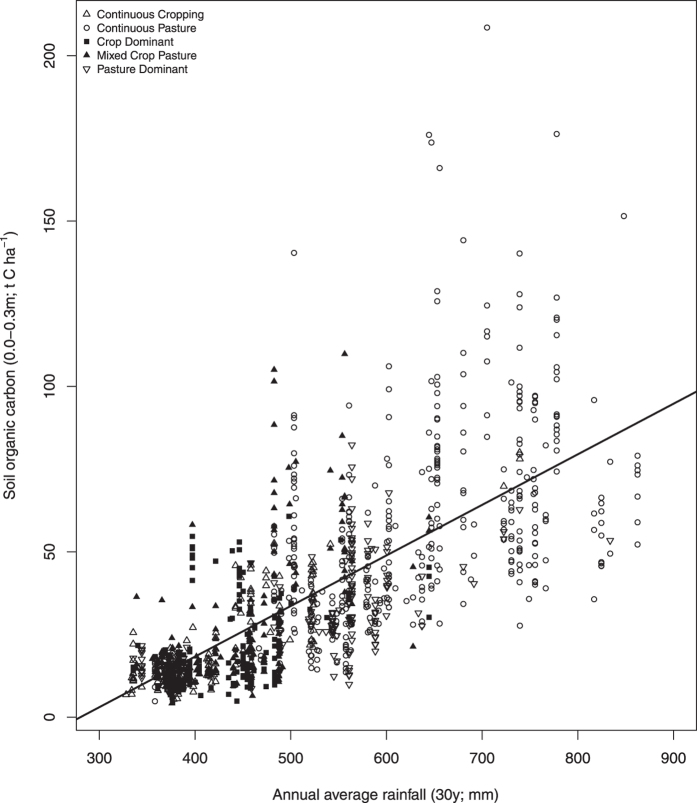
Total soil organic carbon (t C ha−1; 0–0.3 m) and annual average rainfall (mm) based on 30 year history for sites sampled in Western Australia (n = 1348 sample points).Symbols represent different land sequences as depicted in the legend. The solid line represents the regression analysis (p < 0.0001, R2 = 0.54).